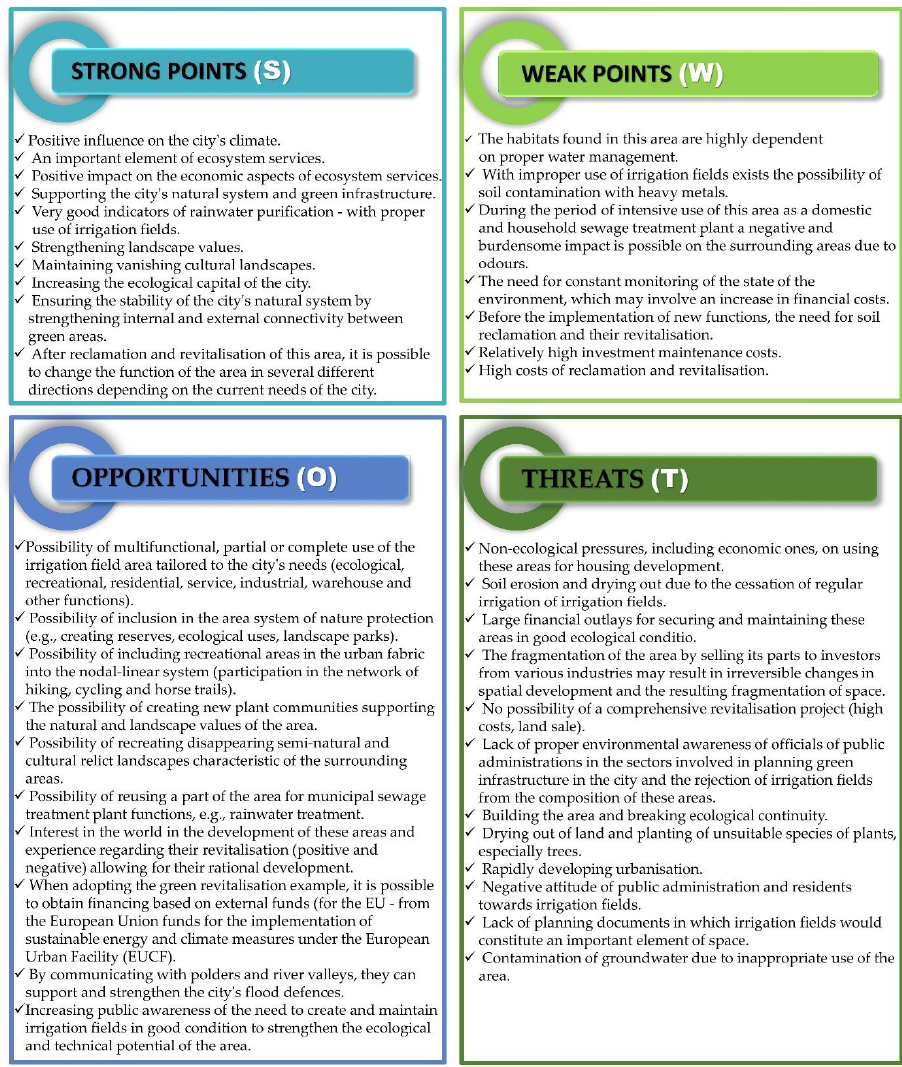
Figure 4. Irrigation fields — SWOT analysis (own elaboration).